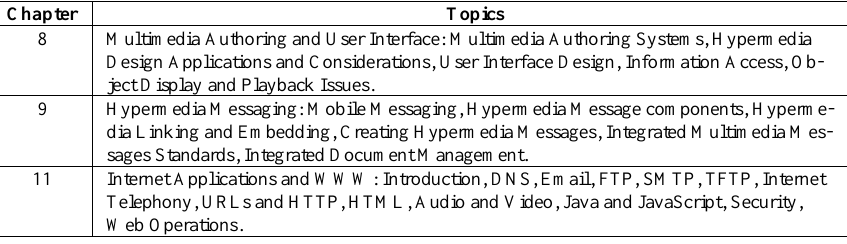
Table 2. Selective syllabus of Multimedia Systems Course Chapter Topics